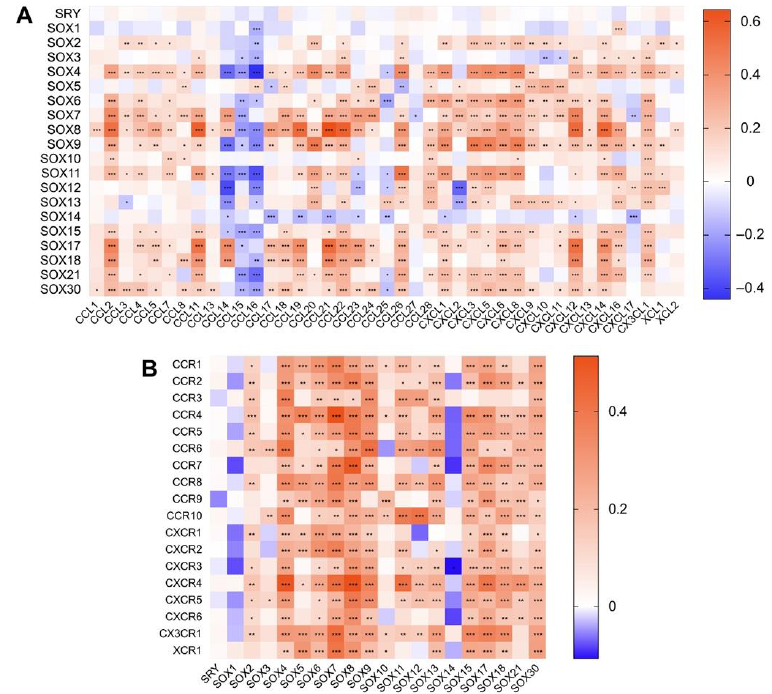
Figure 5. Correlation between the expression of SOX transcription factors and that of immune cell chemotaxis-related genes in hepatocellular carcinoma. ( A ) The relationships between SOX factors expression and the levels of chemokines and ( B ) chemokine receptors were analyzed by the TIMER2. Red indicates positive correlation and blue indicates negative correlation. The darker the color, the stronger the correlation. * p < 0.05, ** p < 0.01, *** p <